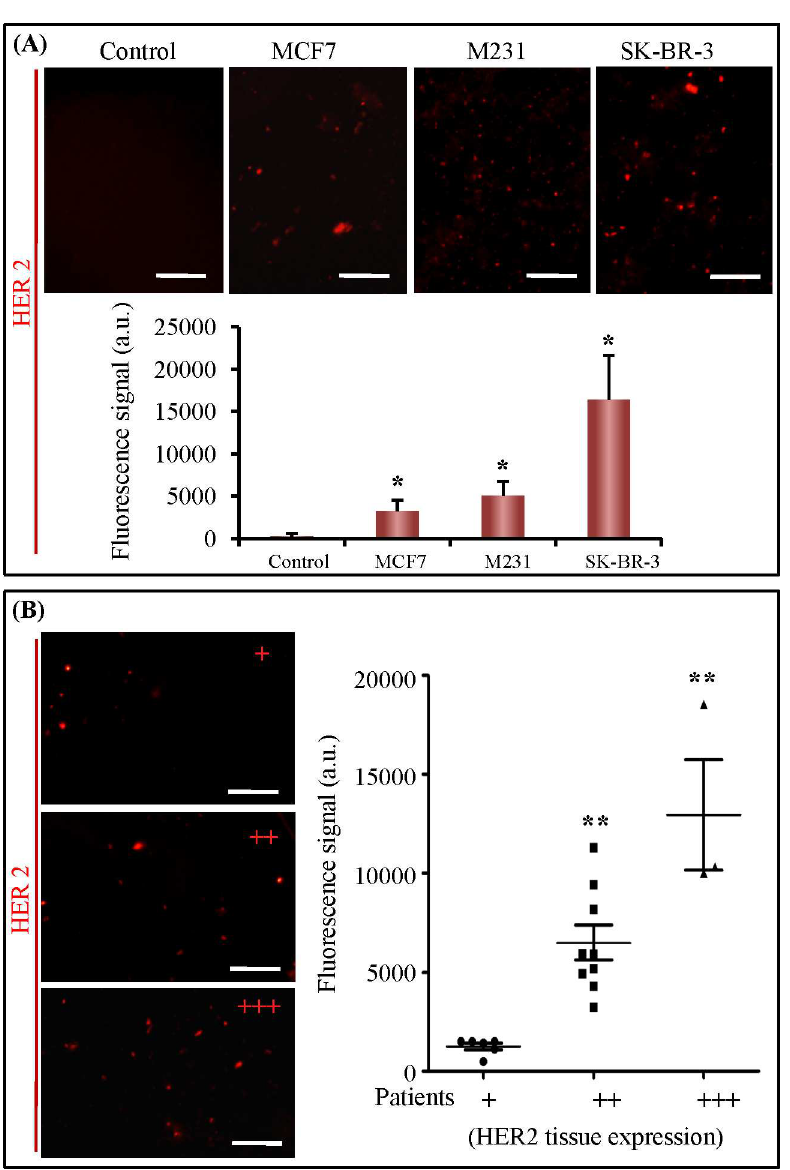
Fig 5. Quantification of HER2-positive exosomes from breast cancer cell lines and clinical patients. (A) Images and quantification of captured HER2-positive exosomes from Ctr, NF, MCF7, M231 and SK-BR-3 culture medium. (B) Images and quantification of capturedHER2-positive exosomesfrom plasma samples of breast cancer patients with different HER2 expressionin primary tumor tissues. HER2+, 6 cases; HER2++, 9 cases; HER2 +++, 3 cases. * , p < 0.05; ** , p < 0.01. The scale bars represent 50 μ m.